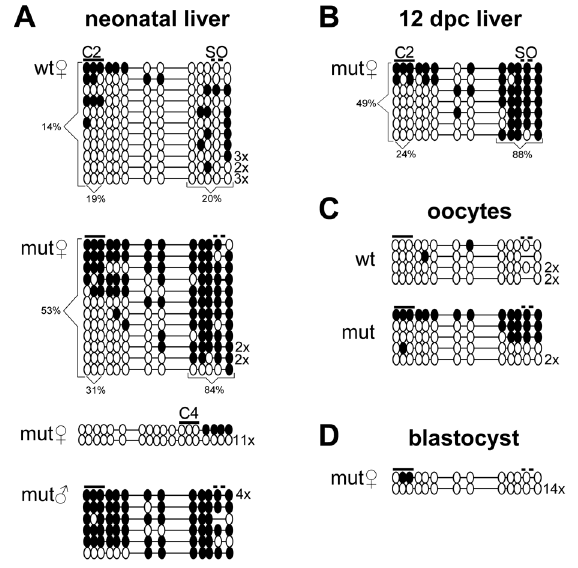
Figure 5. Methylation profiles of WT and mutant ICRs. Each horizontal line of circles represents a unique sequence. Unmethylated and methylated CpGs are presented as open and closed circles, respectively. Multiples of the same methylation pattern are indicated to the right of each sequence. Lines above the circles indicate relative location of CTCF sites 2 and 4 (C2, C4) and the Sox-Oct motifs (SO). The mutant status and the allelic parent of origin are indicated to the upper left of each block of sequences. (A) Bisulfite analysis was performed on neonatal liver from three heterozygous mutant mice and (B) the maternally transmitted mutant ICRs from one 12 dpc embryonic liver. (C) Both WT and mutant bisulfite PCR products from oocytes were the result of four separate reactions each using the DNA from 10–20 oocytes. Oocytes were collected from a combination of homozygous and heterozygous mutant and WT females after superovulation. Each PCR product was cloned separately, and 3–6 clones of each were sequenced. Identical sequences from each product were counted only once. (D) Bisulfite analysis of maternally derived mutant alleles from heterozygous blastocysts was the result of two separate reactions of 6– 10 blastocysts each. PCR products from each reaction were cloned